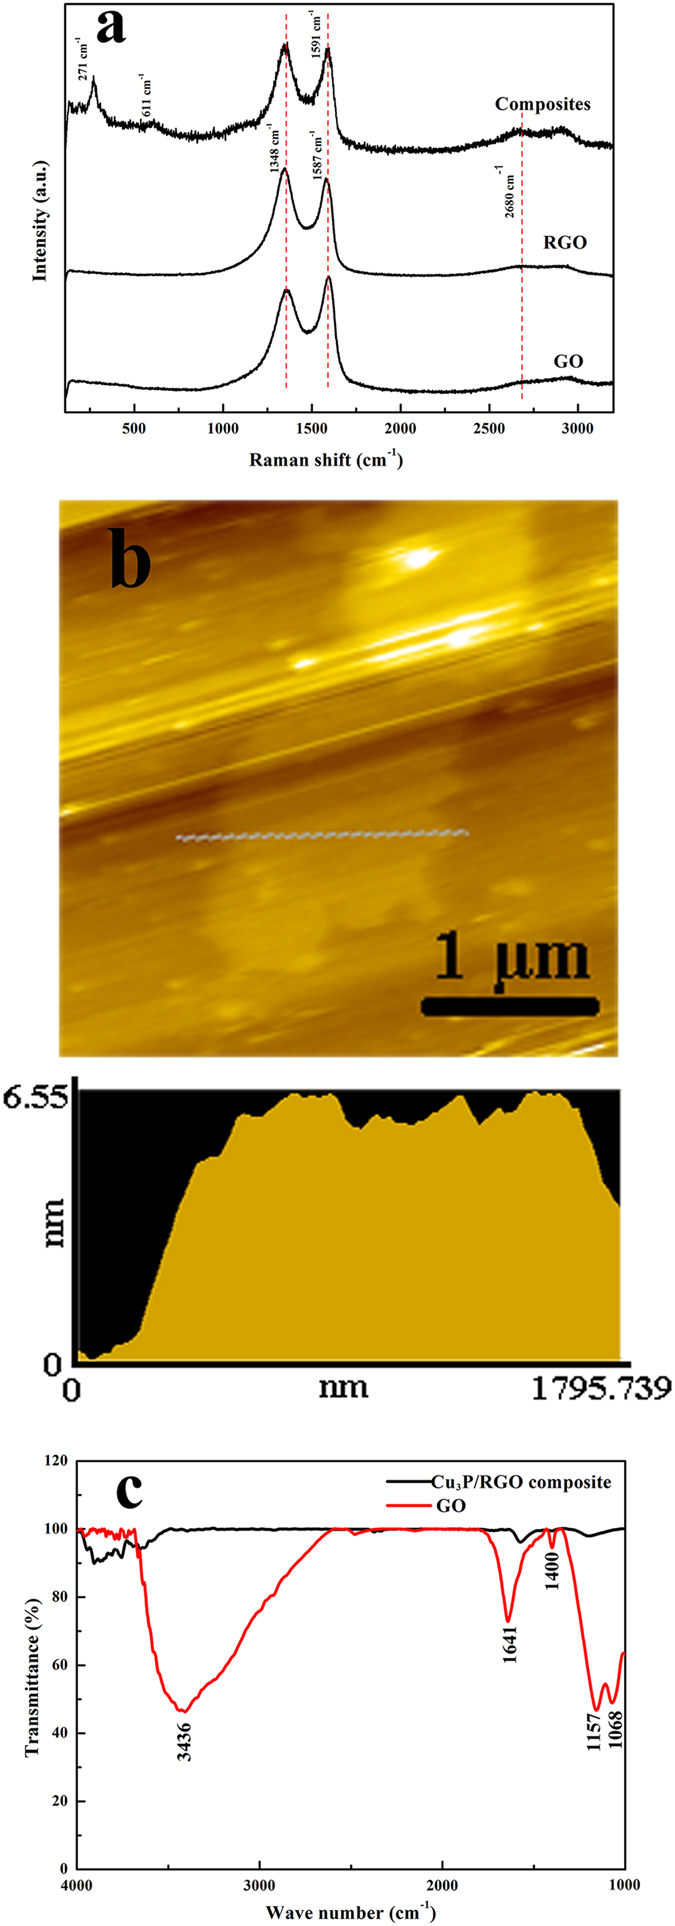
(a) Room-temperature Raman spectra of Cu3P/RGO nanocomposite, GO and RGO, (b) AFM of GO, (c) FTIR of Cu3P/RGO nanocomposite and GO.